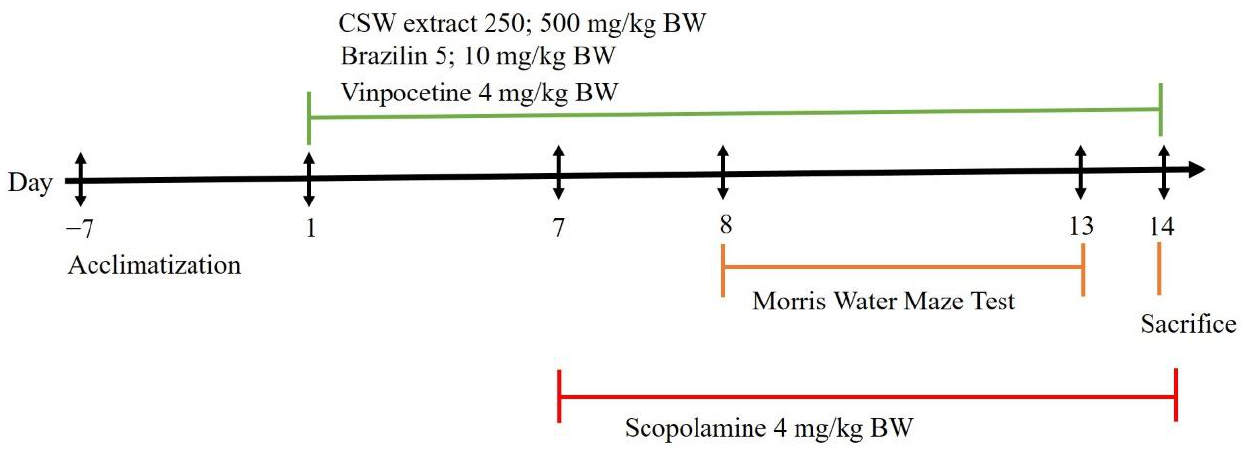
Figure 1. Treatment